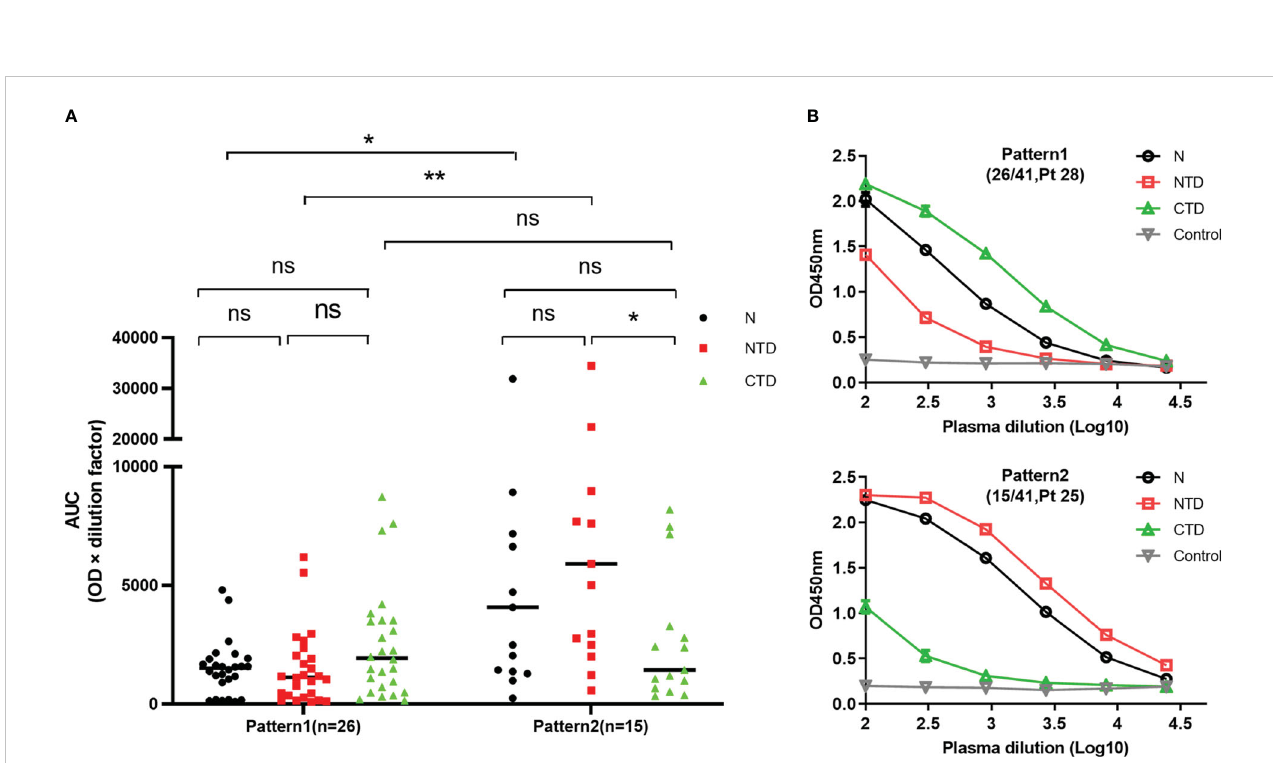
FIGURE 4 Patterns of COVID – 19 patient plasma Ab responses to SARS – CoV – 2 N protein. (A) ELISA results showing the patterns of COVID – 19 patient plasma Ab responses to SARS – CoV – 2 N protein. In Pattern1, Abs in 26 plasma samples reacted with NTD, CTD, and full – length N proteins at comparable levels, While in pattern2, NTD – Abs were dominant in 15 plasma samples. (B) The binding curves of Pattern1 and Pattern2 to NTD, CTD, and full – length N proteins, represented by the tested plasma samples, Pt 28 and Pt 25, respectively. The plasma samples were diluted at 1:100 dilution and followed by 3 – fold serial dilution. Diluted plasma samples were subjected to ELISA to measure anti – N protein Abs. Each dilution was tested in duplicate. AUC was calculated using GraphPad Prism 8. N, full – length; NTD, N – terminal domain; CTD, C – terminal domain; ns, not signi fi cant; Control, supernatant from 293 T cells without transfection; * p < 0.05, ** p <